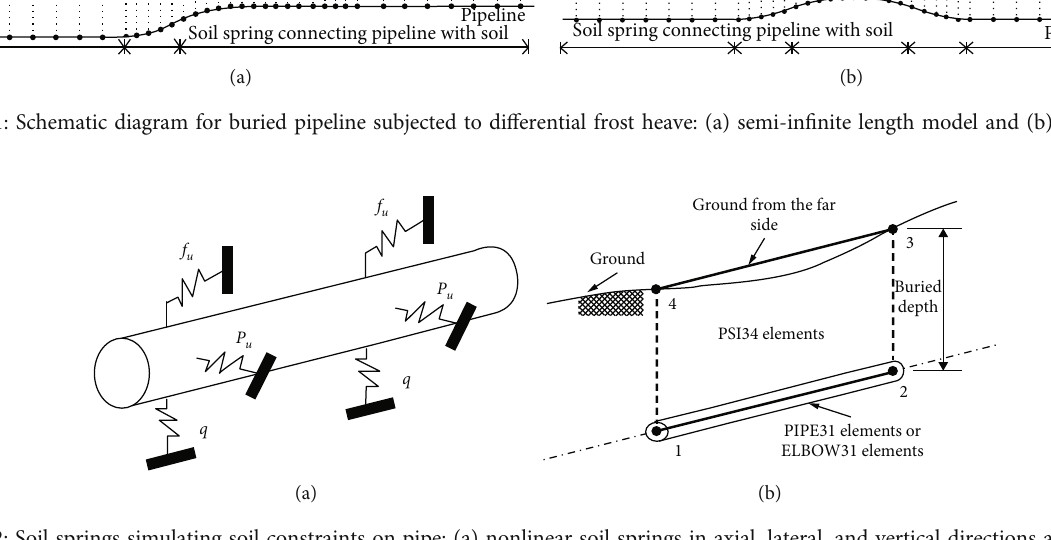
Figure 2: Soil springs simulating soil constraints on pipe: (a) nonlinear soil springs in axial, lateral, and vertical directions and (b) PSI34 elements for pipe-soil